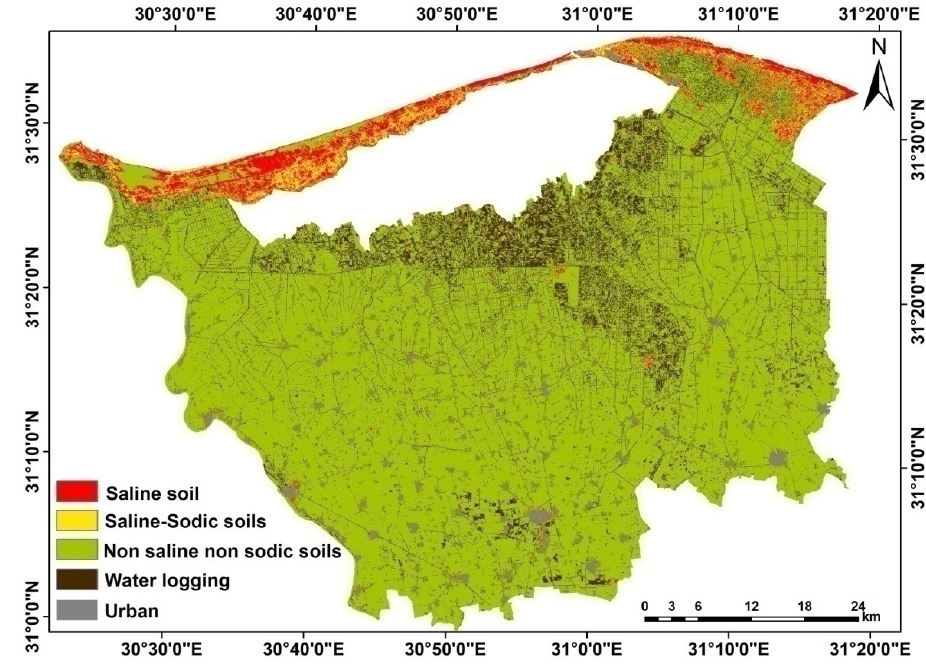
Figure 12 . A 2002 map showing the salt-affected soils in the study area. Table 5 . Accuracy assessment using error matrix in 2002 based on soil survey of 20 soil profiles.